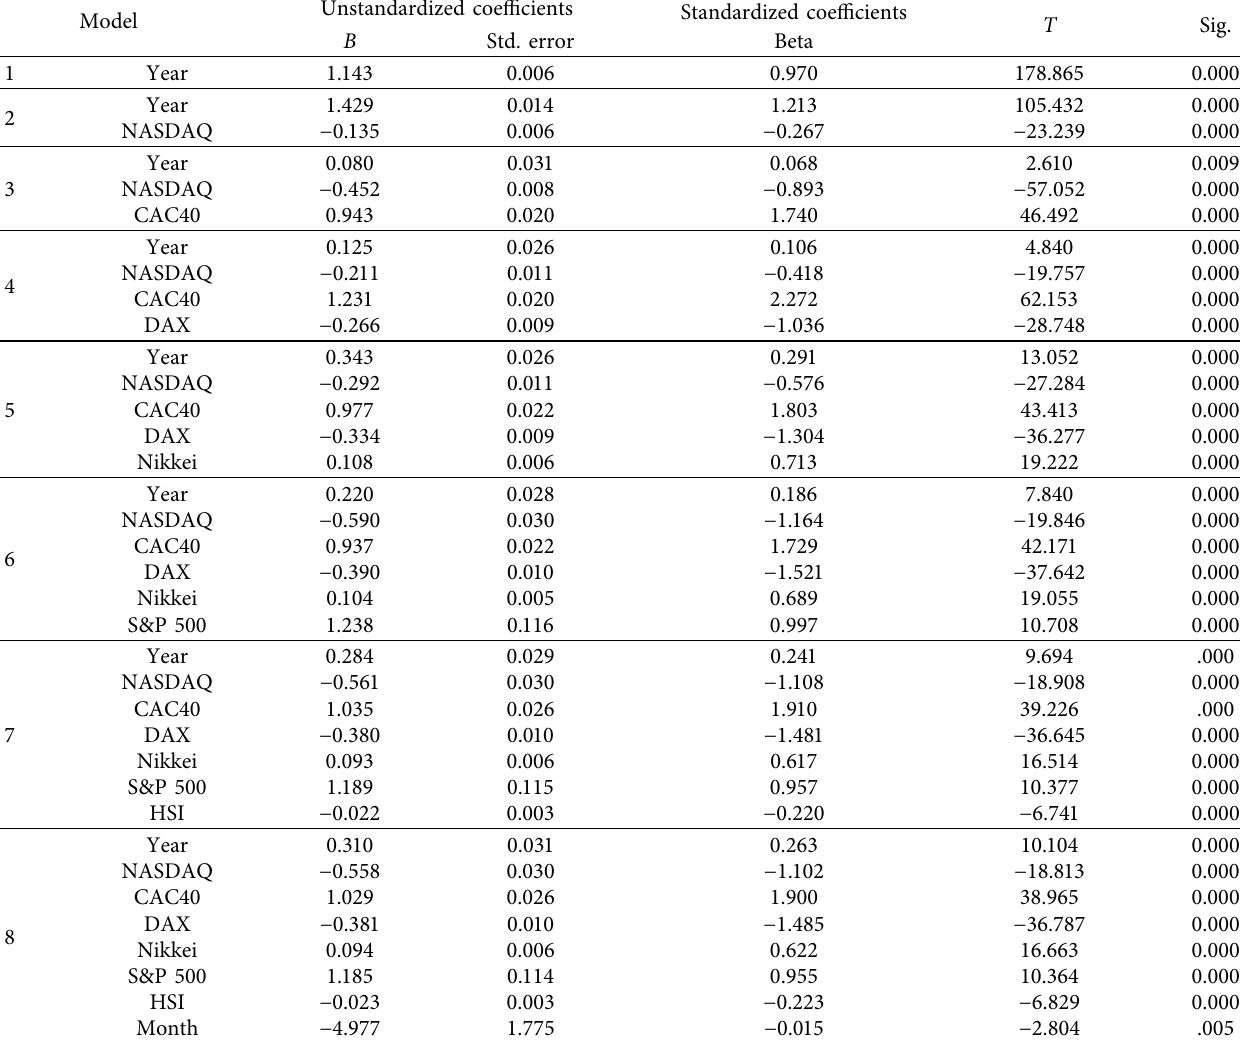
Table 8: Coefficients using stepwise linear regression models without using a constant.